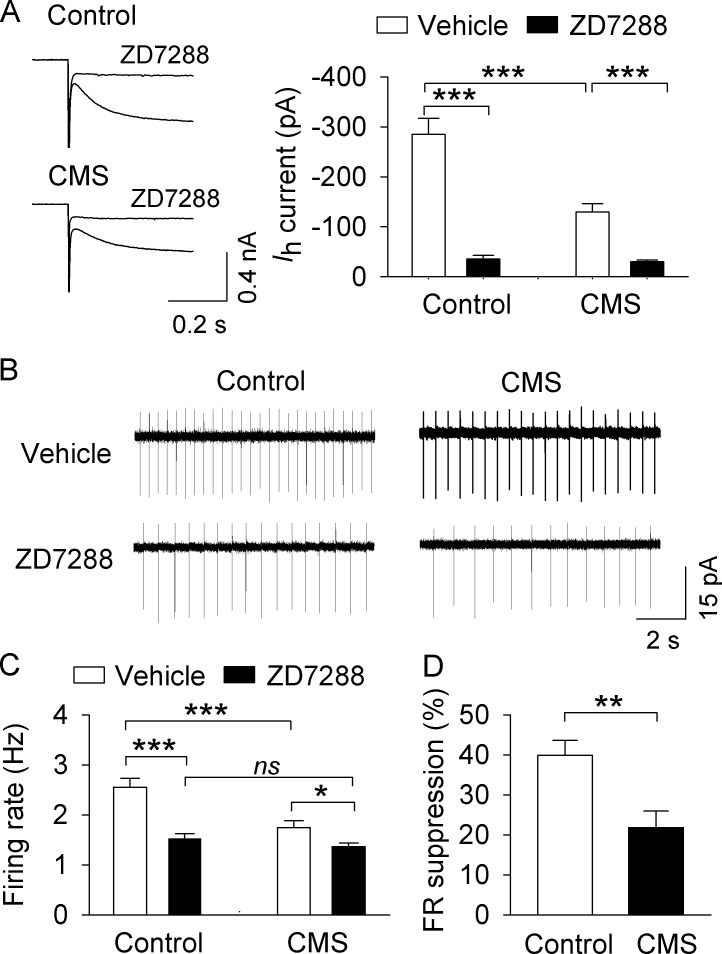
, CMS decreased AP firing in VTA dopamine neurons in midbrain slices.(A) Ih currents recorded at −130 mV in NAc-projecting VTA dopamine neurons in both control (***p<0.001, n = 6 cells from three mice) and CMS groups (***p<0.001, n = 6 cells from three mice) were abolished by the Ih channel blocker ZD7288 (30 μM). (B) Representative AP firing in cell-attached recordings from NAc-projecting VTA dopamine neurons in control and CMS slices before and after ZD7288 (30 µM). (C) The AP firing rate was significantly decreased in the CMS group (n = 13 cells from three mice) compared with the control group (n = 12 cells from four mice; ***p<0.001). ZD7288 significantly decreased the firing rate in both control (n = 11 cells from three mice) and CMS (n = 12 cells from five mice) groups (*p<0.5, ***p<0.001). The mean firing rate was not significantly different between control (n = 11 cells from three mice) and CMS (n = 12 cells from four mice) groups following ZD7288 (p=0.382). (D) The firing rate (FR) suppression (%) by ZD7288 in the control group (n = 11 cells from three mice) was significantly higher than that of the CMS group (n = 12 cells from five mice; **p=0.004).10.7554/eLife.32420.012Figure 5—source data 1.Effects of ZD7288 on Ih current and ex vivo AP firing in VTA dopamine neurons following CMS in Figure 5A,C,D.